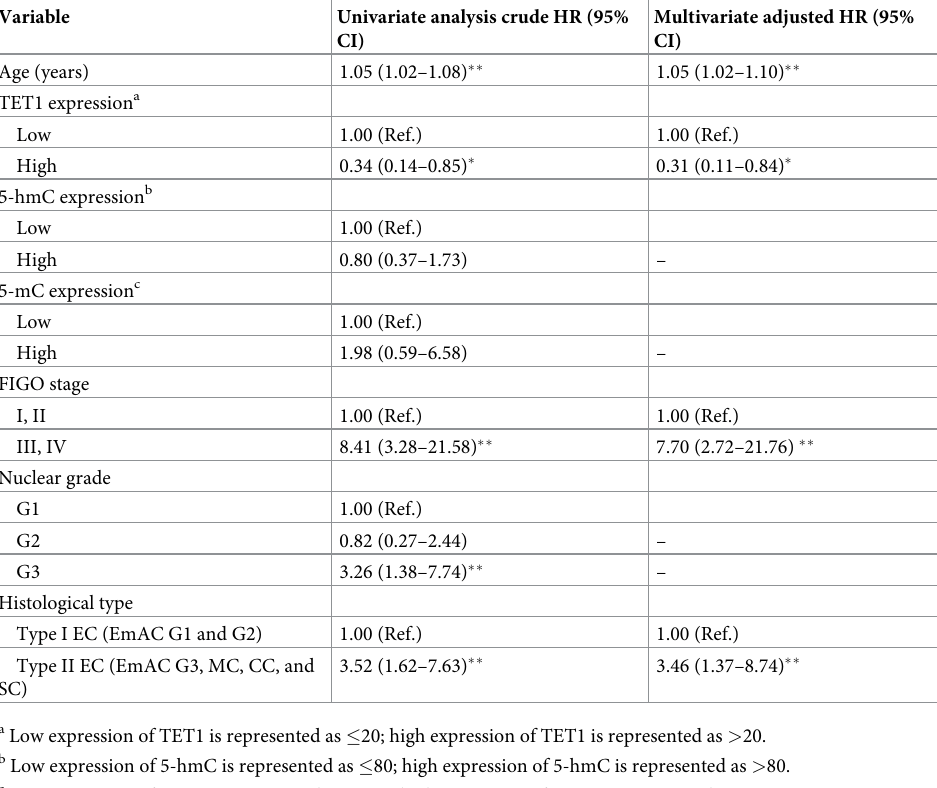
Table 6. Multivariate survival analysis of clinicopathological factors in 86 patients with